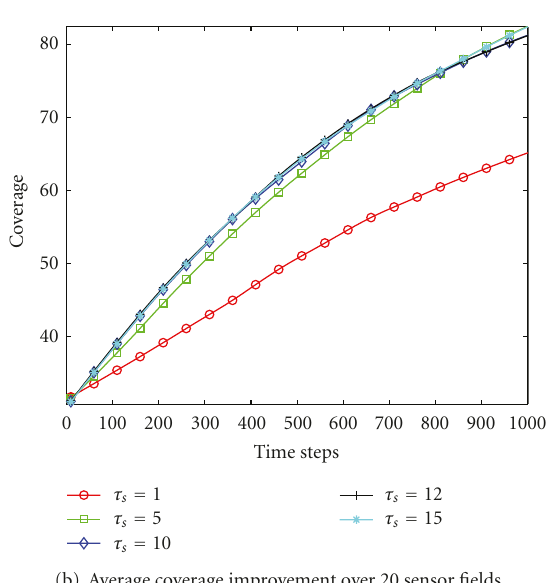
Figure 8: Evaluation of the suspicion threshold τ s optimum